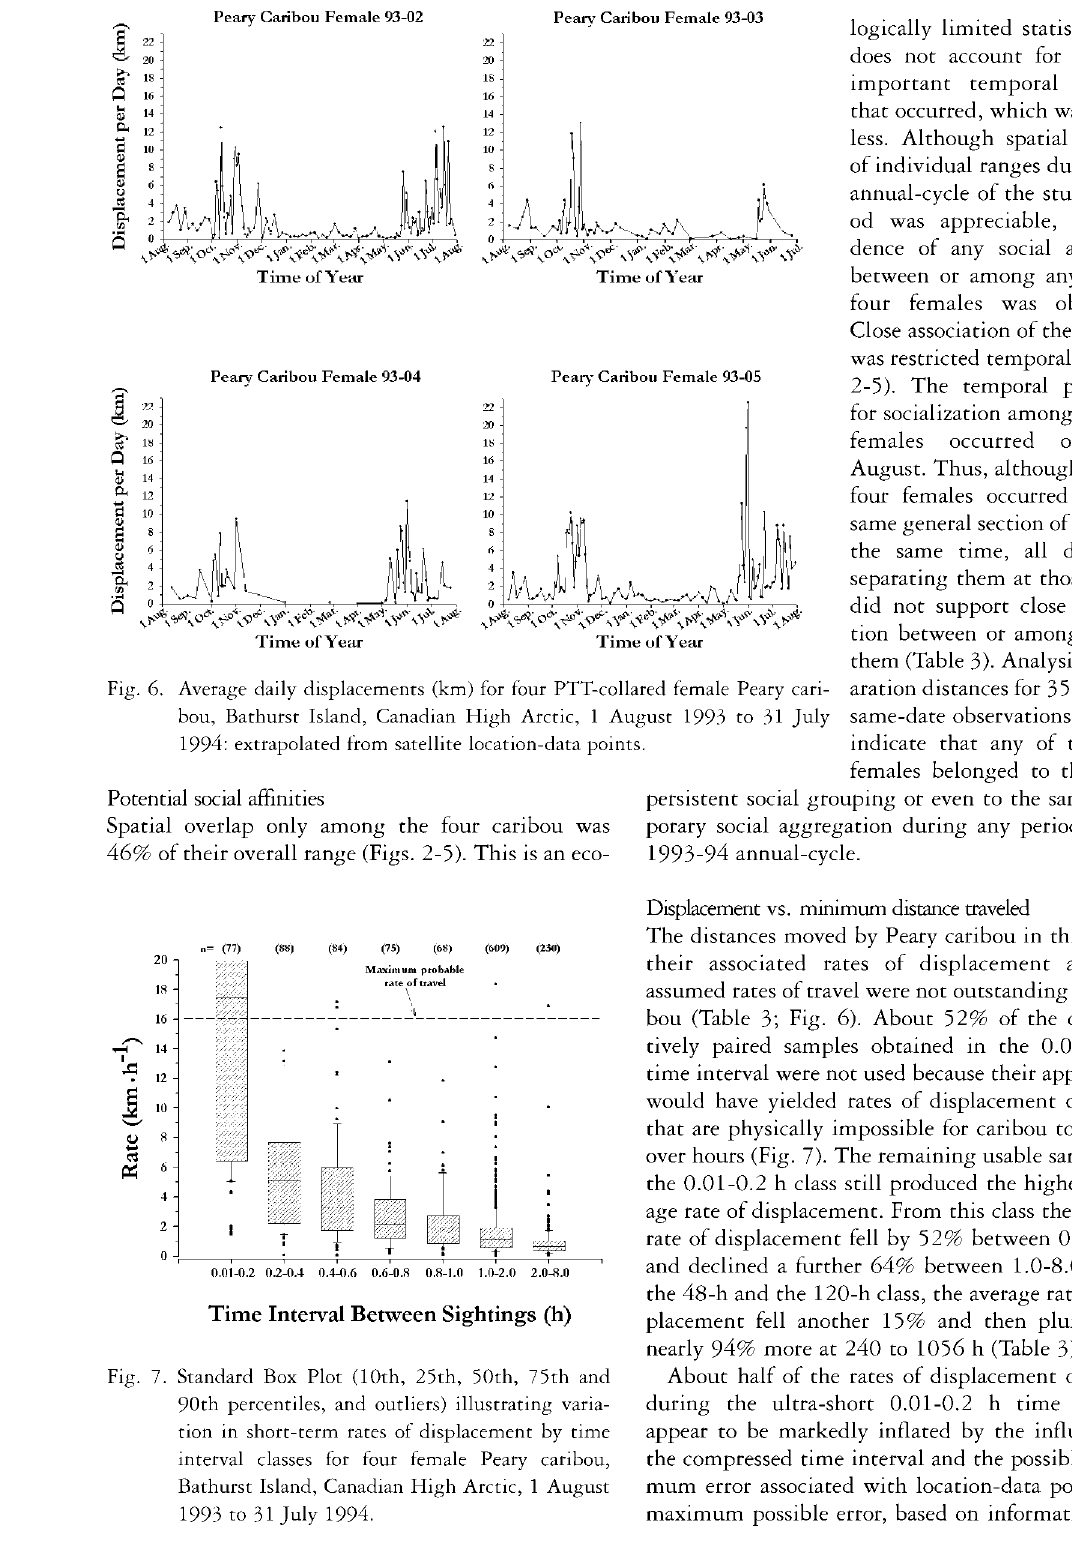
Fig. 7. Standard Box Plot (10th, 25th, 50th, 75th and 90th percentiles, and outliers) illustrating varia¬ tion in short-term rates of displacement by time interval classes for four female Peary caribou, Bathurst Island, Canadian High Arctic, 1 August 1993 to 31 July